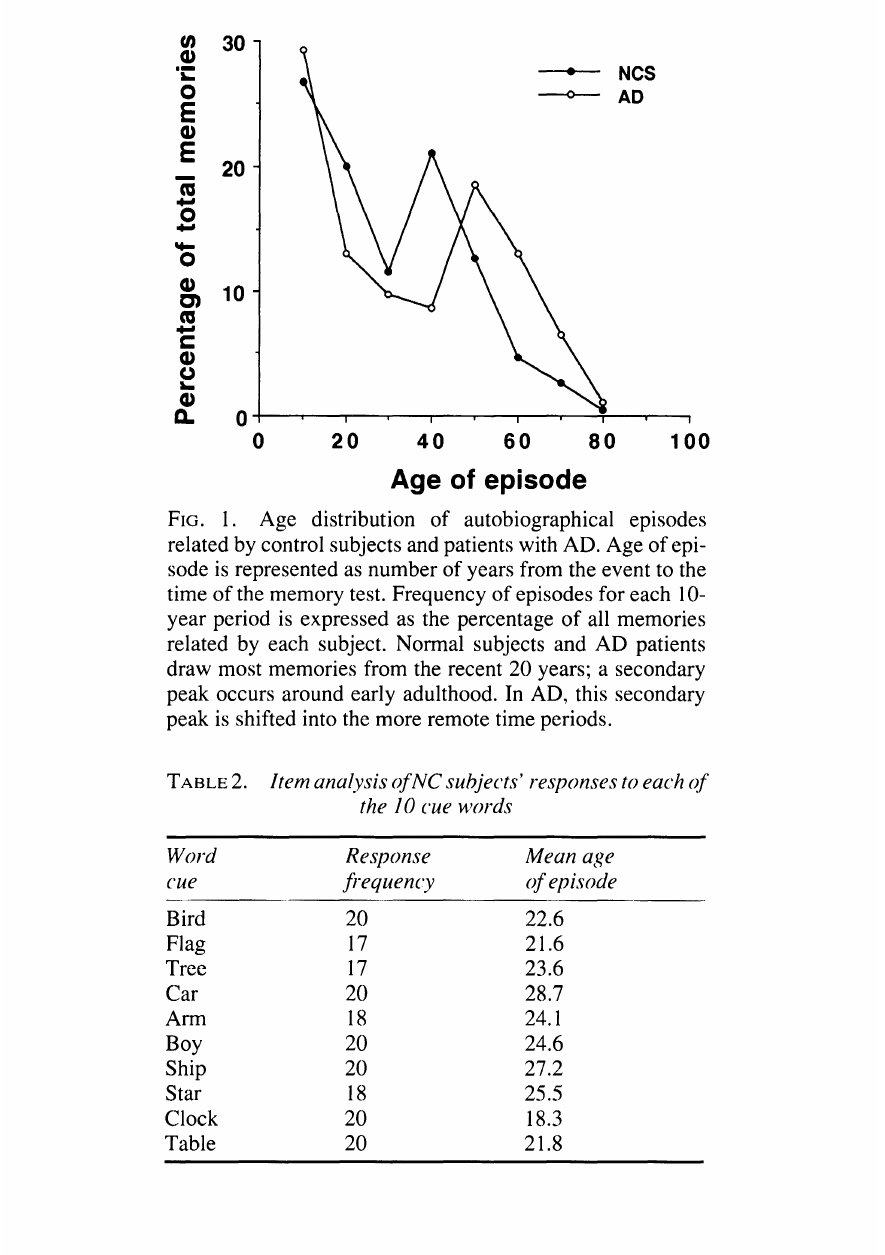
FIG. 1. Age distribution of autobiographical episodes related by control subjects and patients with AD. Age of epi sode is represented as number of years from the event to the time of the memory test. Frequency of episodes for each 10- year period is expressed as the percentage of all memories related by each subject. Normal subjects and AD patients draw most memories from the recent 20 years; a secondary peak occurs around early adulthood. In AD, this secondary peak is shifted into the more remote time periods. TABLE 2. Item analysis ofNe subjects' responses to each (~l the 10 cue words